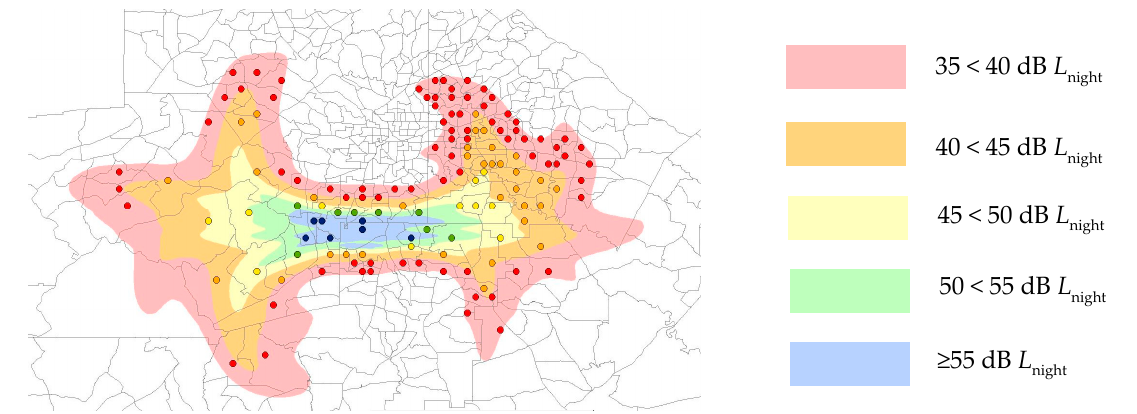
Figure 1. Nighttime aircraft noise contours and census tract boundaries around Hartsfield–Jackson Atlanta International Airport (ATL) airport, modeled using 84 nights of data from 2014–2015. Points indicate the population weighted centroid of each census tract, colored according to the noise contour in which it is located.